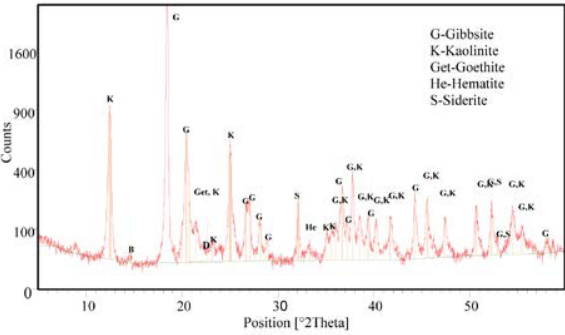
Figure 3. Diffractogram of the standard bauxite sample NBS 697 (Dominican) – Standard NBS 698 is a hydrargillite bauxite with hema- tite content. In addition to gibbsite, this sample also con- tains anatase, goethite, and hematite (Figure 4).